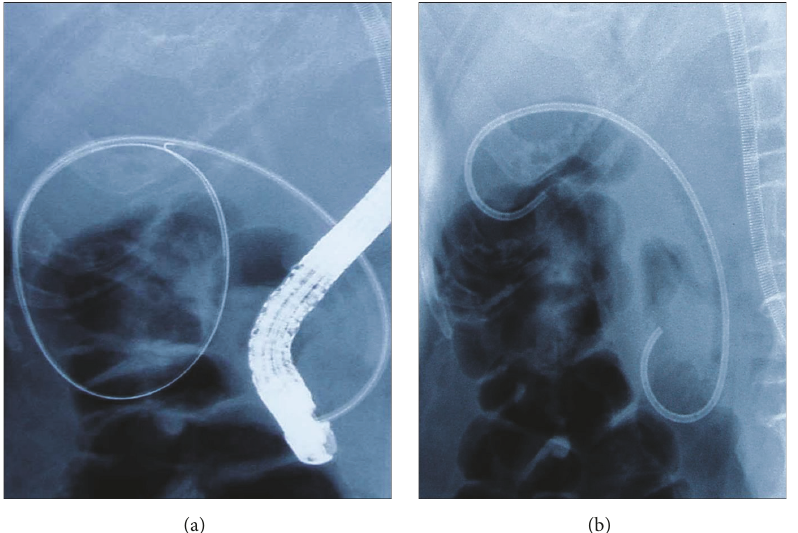
Figure 2: (a) Fluoroscopic image of a guidewire coiled in the gallbladder. (b) Fluoroscopic image of a stent extending from the duodenum into the